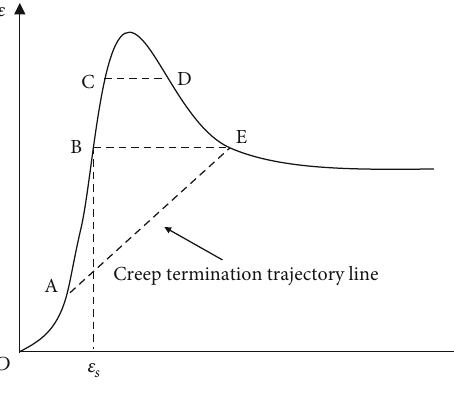
Figure 1: Creep and stress-strain